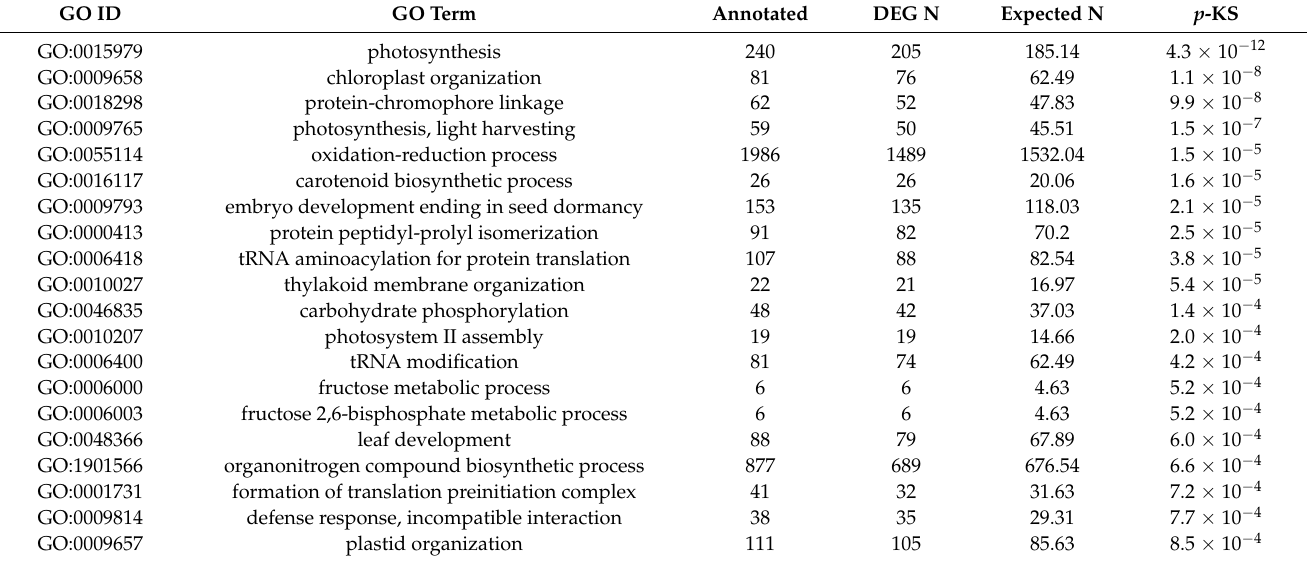
Table 2. Top 20 GO terms in GO enrichment analysis of DEGs.